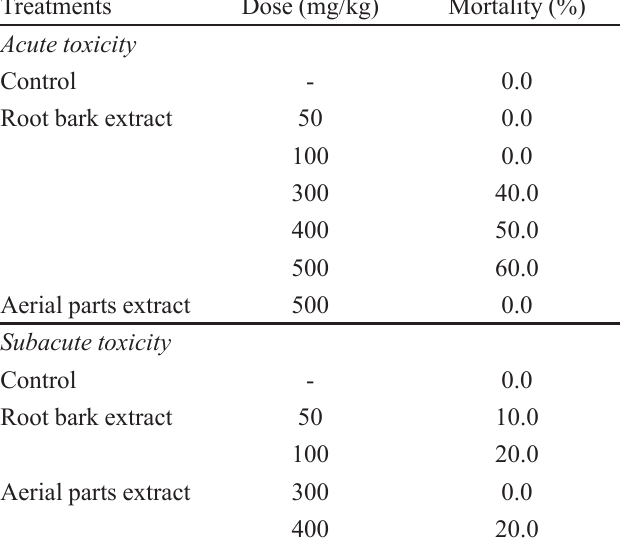
TABLE I - Effect of acute and subacute administration of D. americana extracts on mortality in mice. N =10